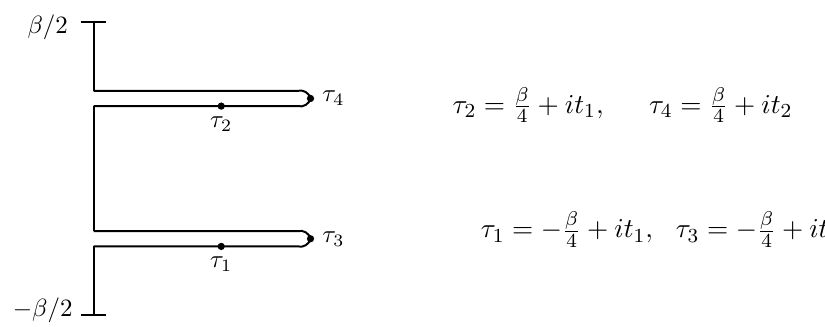
Figure 11 . Time ordering prescription for the out-of-time ordered four point function at (cid:12)nite inverse temperature (cid:12) . Note that the time operator insertion at (cid:28) 3 acts before the operator insertion at (cid:28) 2 , even though in real time t 1 = Im( (cid:28) 2 ) is earlier than t 2 = Im( (cid:28) 3